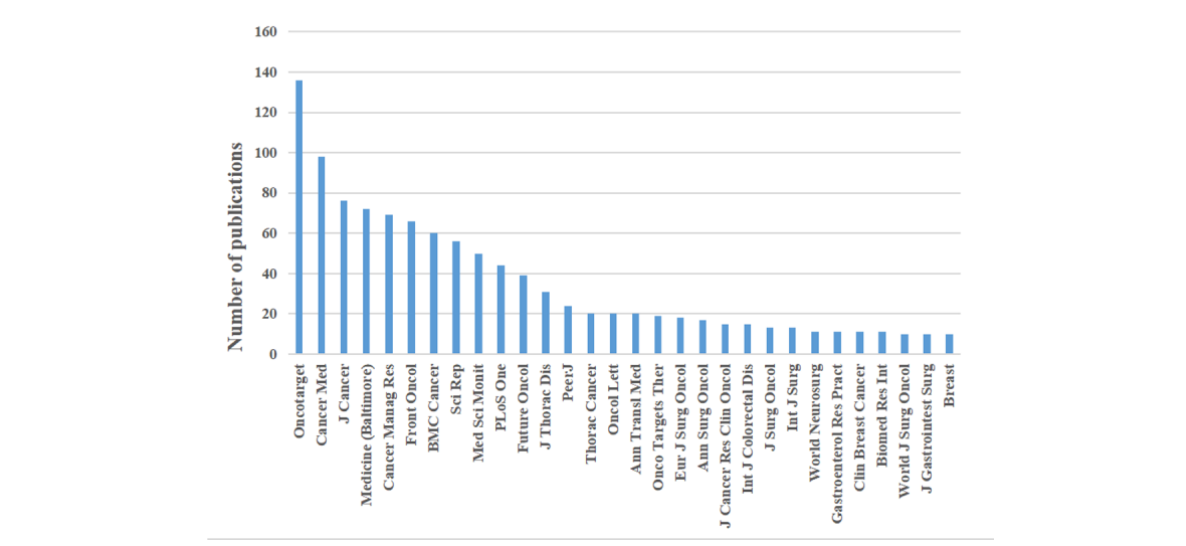
Number of publicationsAffiliations of corresponding authors